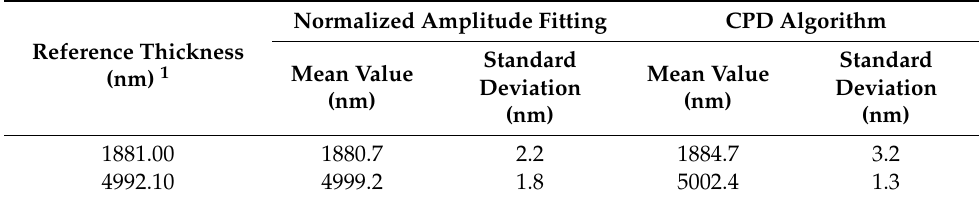
Table 4. Measurement results for thicker films.